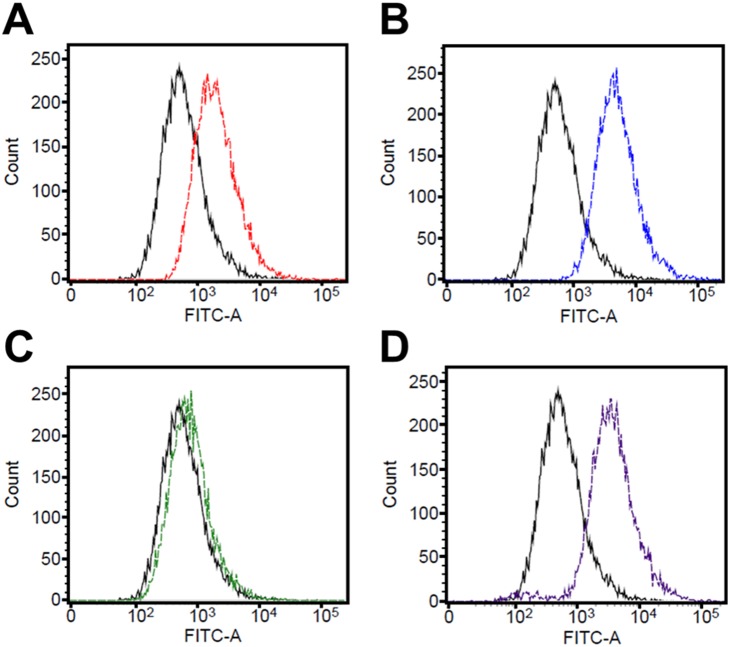
Measurement of oxidative stress induced by antibiotics.Intracellular superoxide-anion generation was measured using DHR 123. Fluorescence intensity was determined using flow cytometry and is represented as a histogram. FITC-A indicates the intensity of green fluorescence and the number of cells exhibiting the corresponding fluorescence intensity (amount of ROS production). The fluorescence histograms are of the samples before and after antibiotic treatment; solid and dotted lines are untreated cells and antibiotic-treated cells, respectively. (A) Amp, (B) Km, (C) Tc, (D) Nor. A shift to stronger fluorescence indicates a greater generation of oxidative stress.